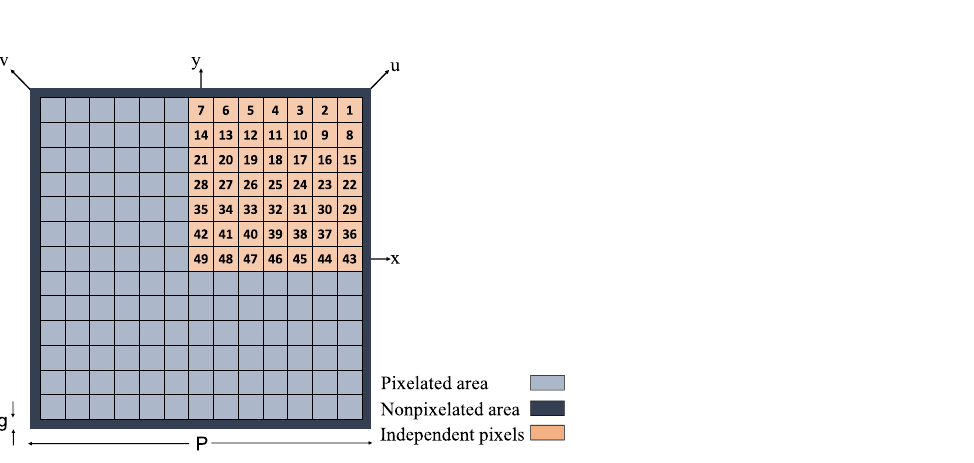
Figure 6. Schematic of the pixelated polarization converter unit